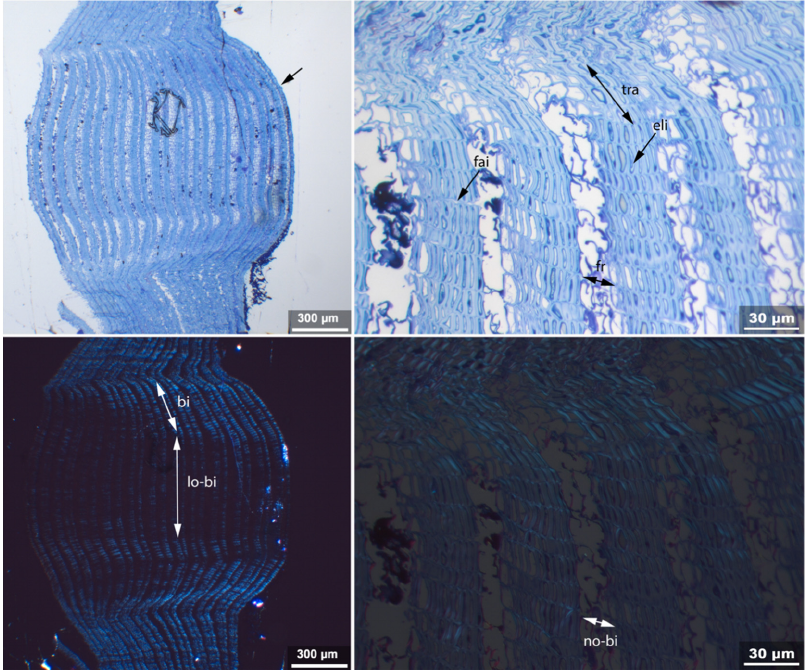
Figure 11. Reference sample. Lenticel with fanned out thick-walled bands ( top left ). Detailed image of cell structure ( top right ) shows ellipsoid lumen (eli) of thick-walled cells and fractures (fr) of thin-walled cells. Birefringence of thick-walled cells is low at lenticel centre (lo-bi, bottom left ) and rises at the transition to normal phellem (bi), while it is absent in thin-walled fractured cells (no-bi, bottom right